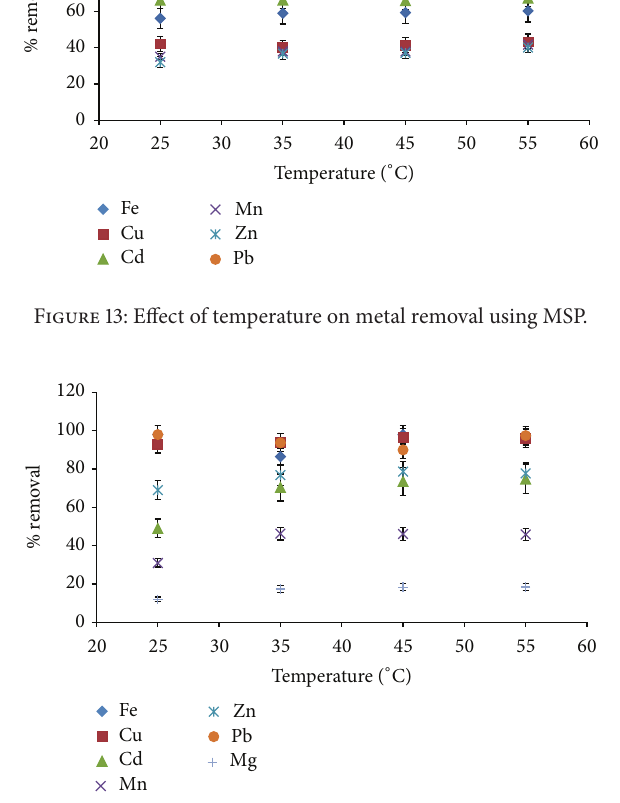
Figure 14: Effect of temperature on metal removal using